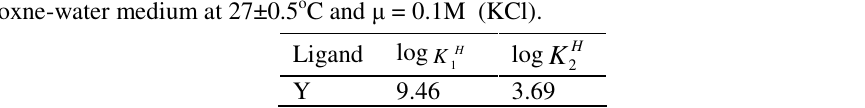
Table 1. Proton-ligand stability constants of secondary ligand (Y) in 75: 25% (v/v)